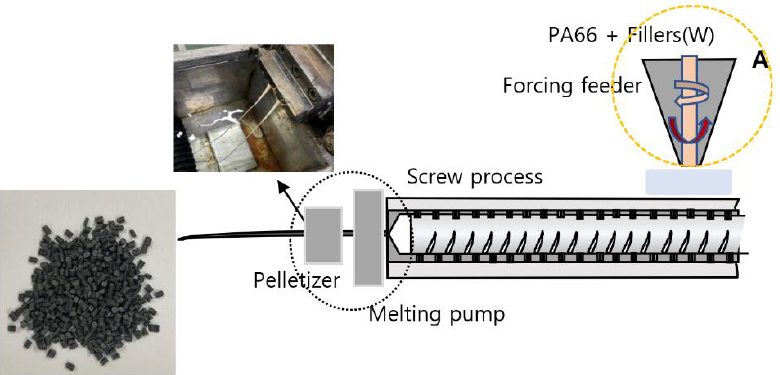
Figure 1. Process of manufacturing pellets: (A) process of mixing tungsten microparticles and powdered PA66 polymers.